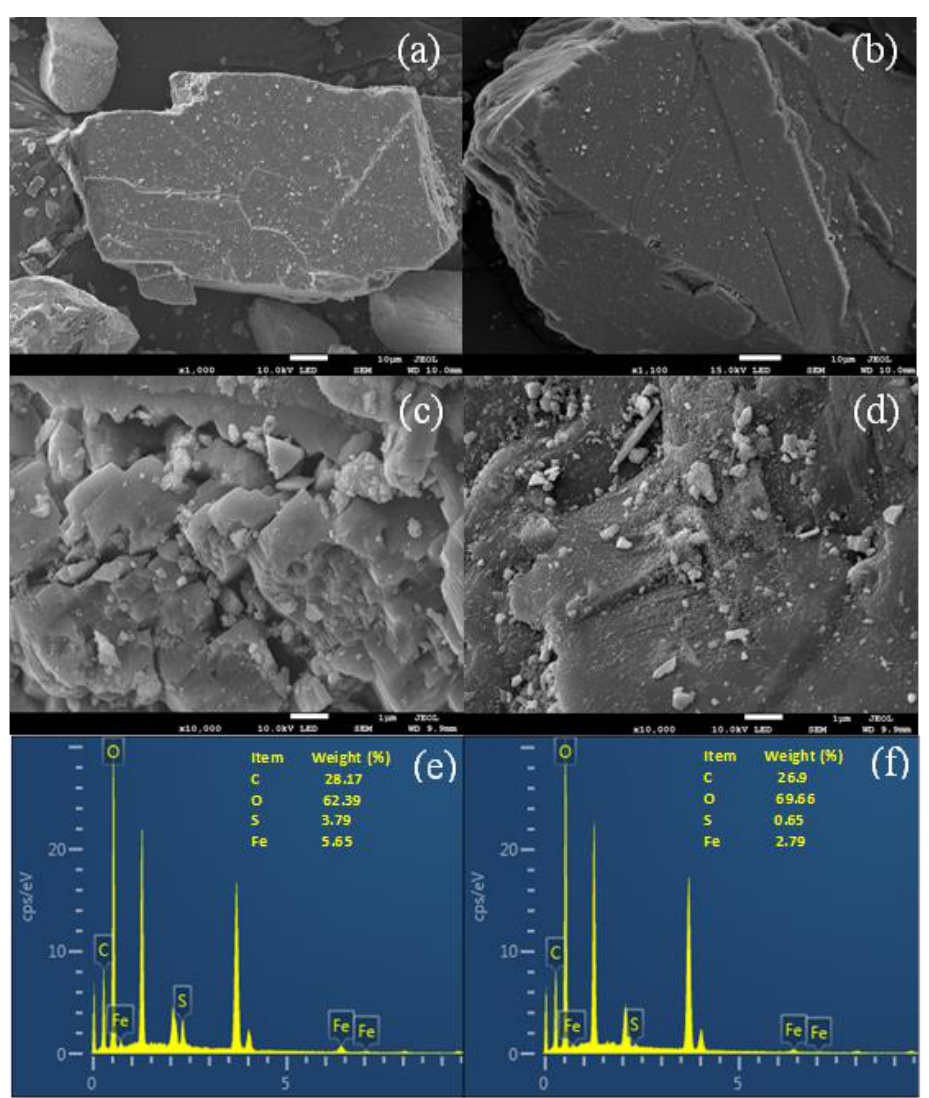
Figure 6. Scanning electron microscopy (SEM) images: ( a ) raw pyrite, ( b ) raw ZVI, ( c ) reacted pyrite, ( d ) reacted ZVI and energy-dispersive spectroscopy (EDS) spectra of reacted materials, ( e ) pyrite, and ( f ) reacted ZVI.